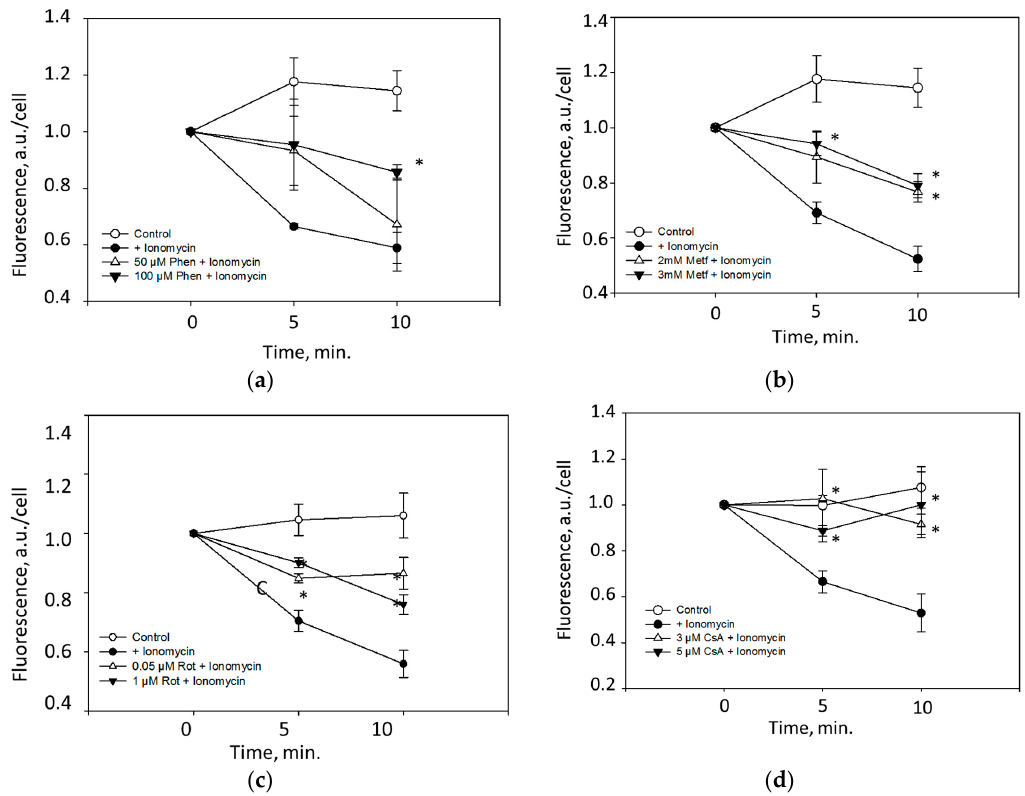
Figure 8. Effects of phenformin, metformin, rotenone and cyclosporin A on MPTP opening in Figure 8. E ff ects of phenformin, metformin, rotenone and cyclosporin A on MPTP opening in neuronal neuronal cells. Pure neuronal cultures prepared treating CGC cultures with Ara-C (see 2.2 section) cells. Pure neuronal cultures prepared treating CGC cultures with Ara-C (see Section 2.2) were were pre-incubated for 1 h with: ( a ) 50 µM and 100 µM phenformin (Phen), ( b ) 2 mM and 3 mM pre-incubated for 1 h with: ( a ) 50 µ M and 100 µ M phenformin (Phen), ( b ) 2 mM and 3 mM metformin metformin (Met); ( c ) 0.05 µM and 1 µM rotenone (Rot); and ( d ) 3 µM and 5 µM cyclosporine A (CsA). (Met); ( c ) 0.05 µ M and 1 µ M rotenone (Rot); and ( d ) 3 µ M and 5 µ M cyclosporine A (CsA).